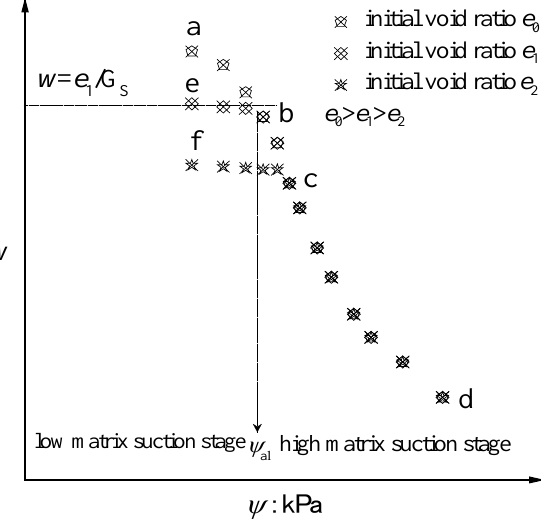
Figure 1. Schematic sketch of soil-water characteristic curves (SWCCs) in terms of gravimetric water content of unsaturated soils with different initial void ratios.